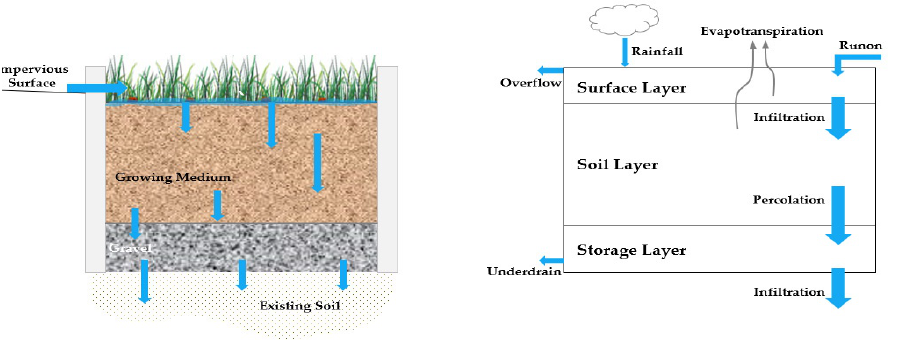
Figure 3. A typical bioretention cell [21].